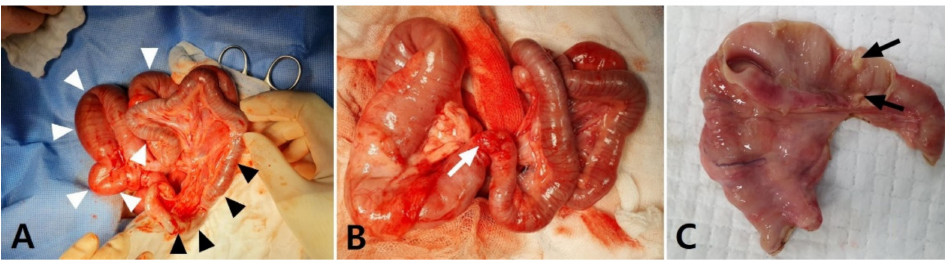
Figure 2. Intraoperative photographs of a dog that presented with postoperative small-bowel obstruction with small-bowel fecal signs in computed tomography images. ( A ) The proximal jejuna were adhered, inducing plication at acute angles (white arrowheads); they were also markedly dilated and hyperemic. The distal jejunum and ileum were mildly dilatated and contained hard intestinal contents that could not be moved or crushed (black arrowheads). ( B ) After the release of the entrapped jejunal segments, a fibrinous adhesive strand was observed to have tightened the middle region of the jejunum, inducing jejunal stenosis (white arrow). A large discrepancy in the intestinal lumen was identified between the proximal and distal jejunum to the stenosed lesion. ( C ) Thick, fibrous adhesive tissue developed between the adjacent serosa and reduced the intestinal lumen (black